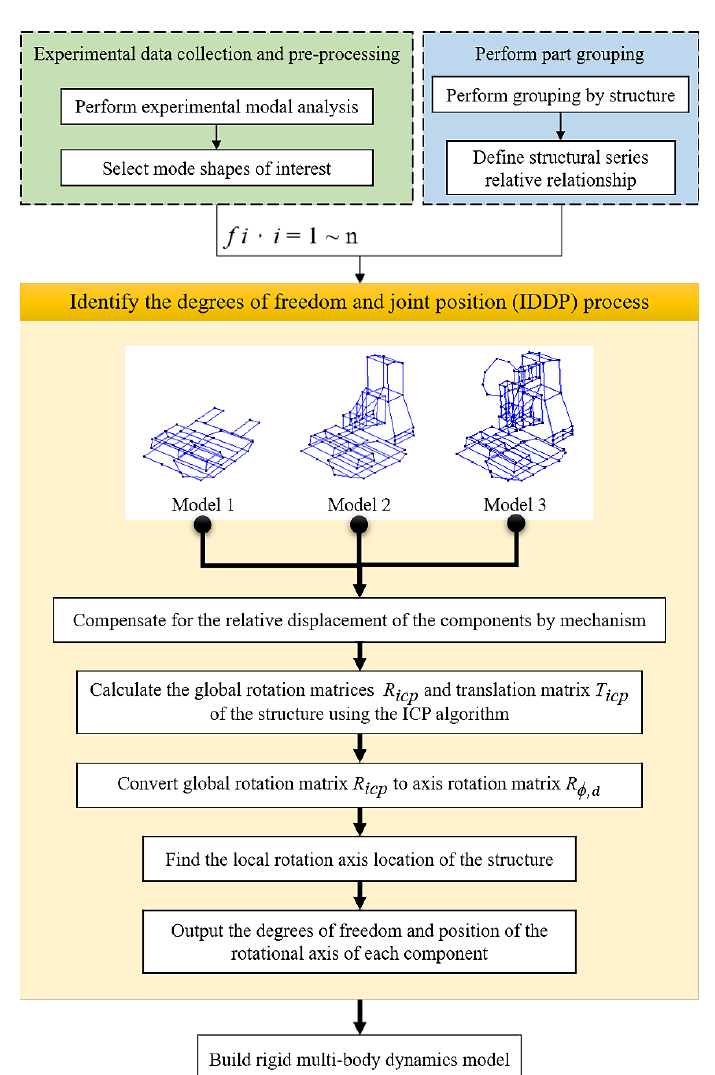
Figure 3. Flowchart of the IDDP.